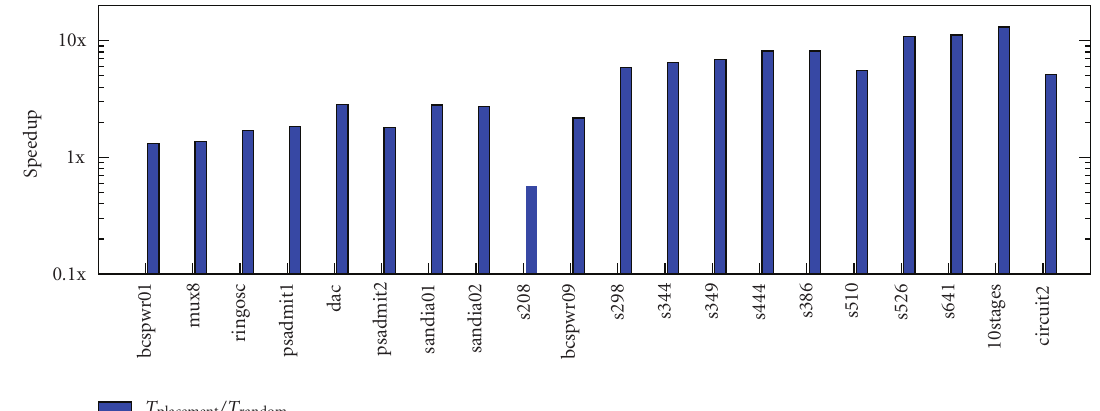
Figure 14: Impact of Placement at 25PEs (Sparse Matrix Solve computation).